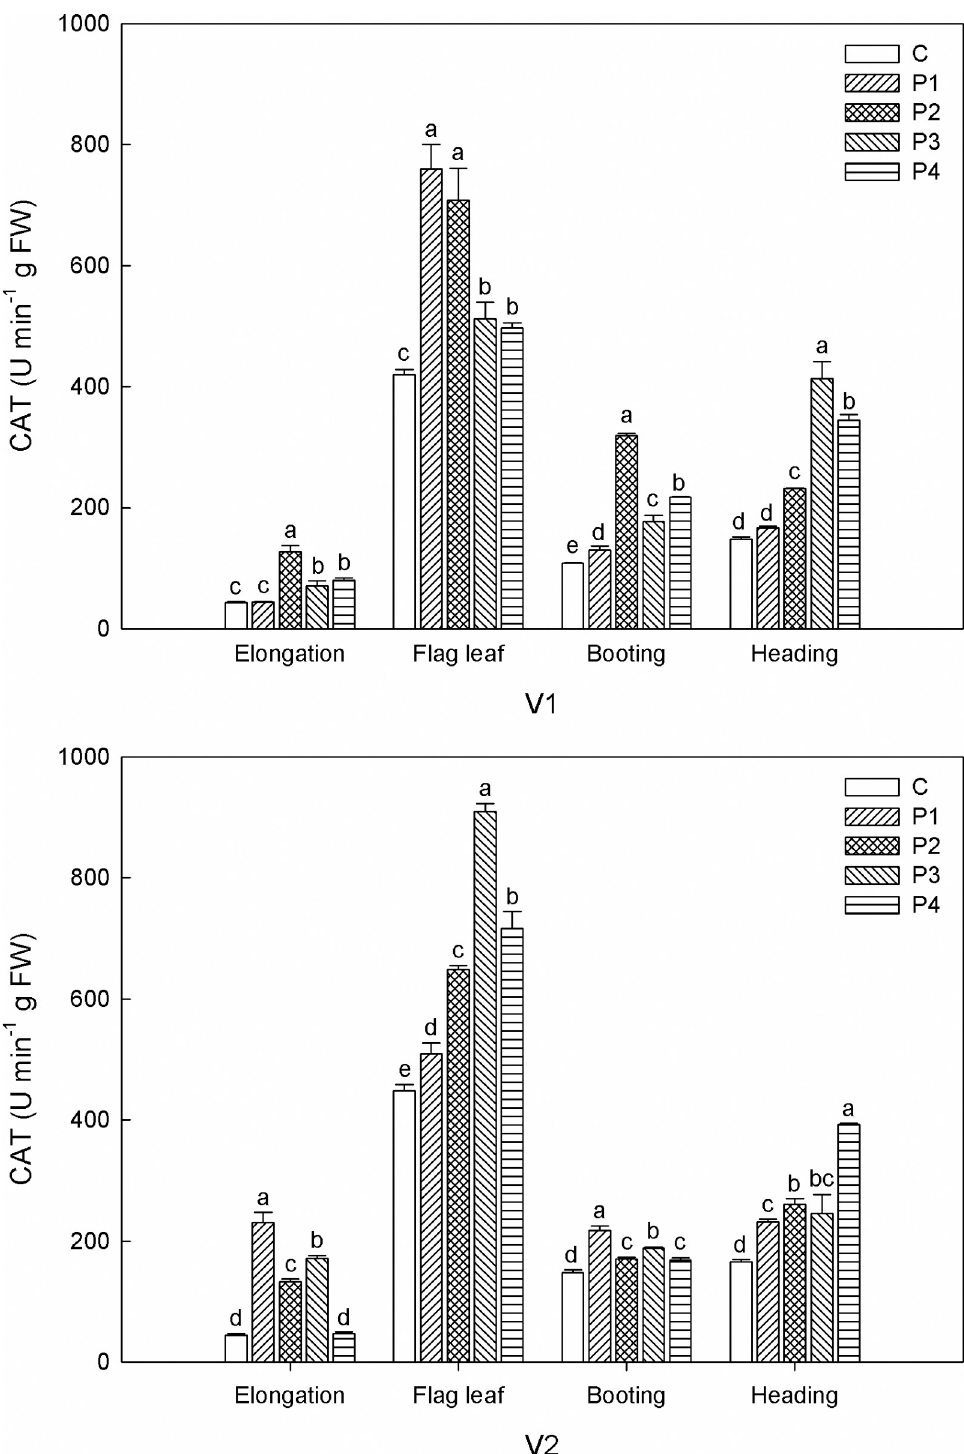
Fig 1. Effects of seed priming on CAT under salt stress at different growth stages. V1: CFSH30, V2: 1230, C: control, P1: H 2 O 2 , P2: NaCl, P3: KCl, P4: MgSO 4 . Within the same growth stage, the bars marked with different lowercase letters are statistically different at the 0.05 probability level.